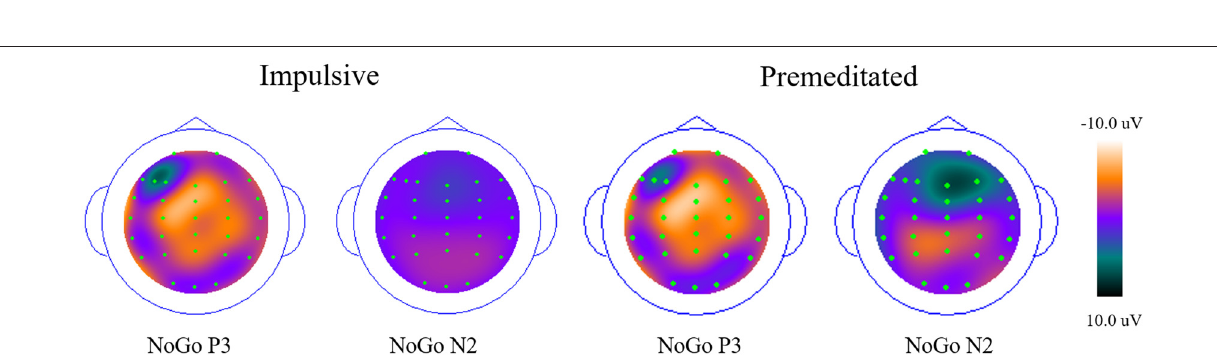
FIGURE 3 | Topographic maps of ERP waveforms (P3 and N2) from the nogo condition across impulsive and premeditated aggression